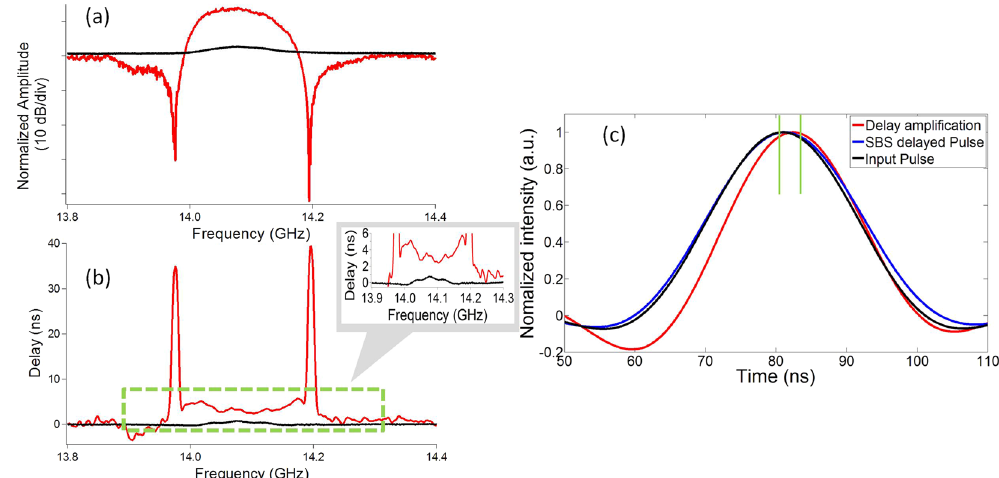
Figure 4. Low power delay line. ( a ) Normalized amplitude response of the 100 MHz filter with a sharp roll-off, and ( b ) the measured delay response. Inset: a zoom of the delay. Black: SSB response for only a gain resonance. Red: RF interference and losses switched ON. ( c ) The pulse delay in the RF signal processor with only the SBS gain resonance (Blue) and with the RF resonance and the loss pumps switched ON (Red) compared to the Input pulse